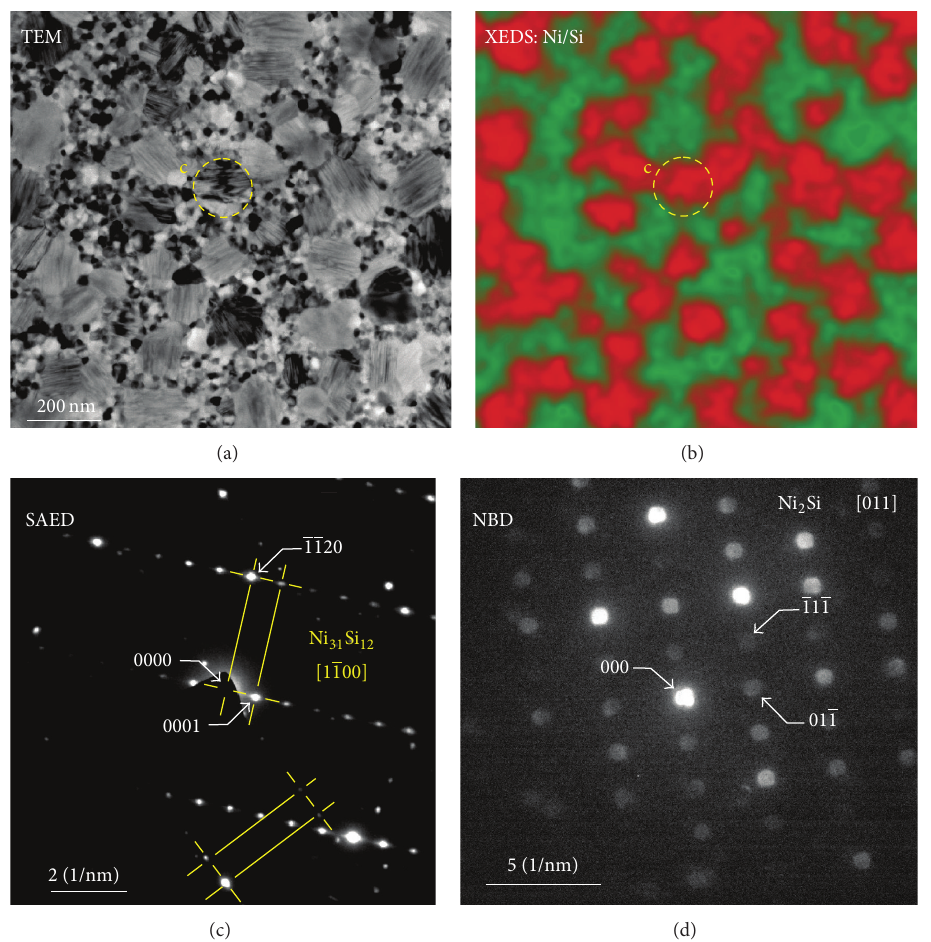
Figure 7: Results obtained from plan-view specimen of the contact annealed at 600 ∘ C: (a) plan-view TEM micrograph; (b) map representing XEDS nickel/silicon signal ratio obtained for the same area as TEM image presented in (a); (c) selected area diffraction pattern obtained for the area marked with the circle in (a) and (b); (d) NBD pattern obtained for a grain located in the area with small